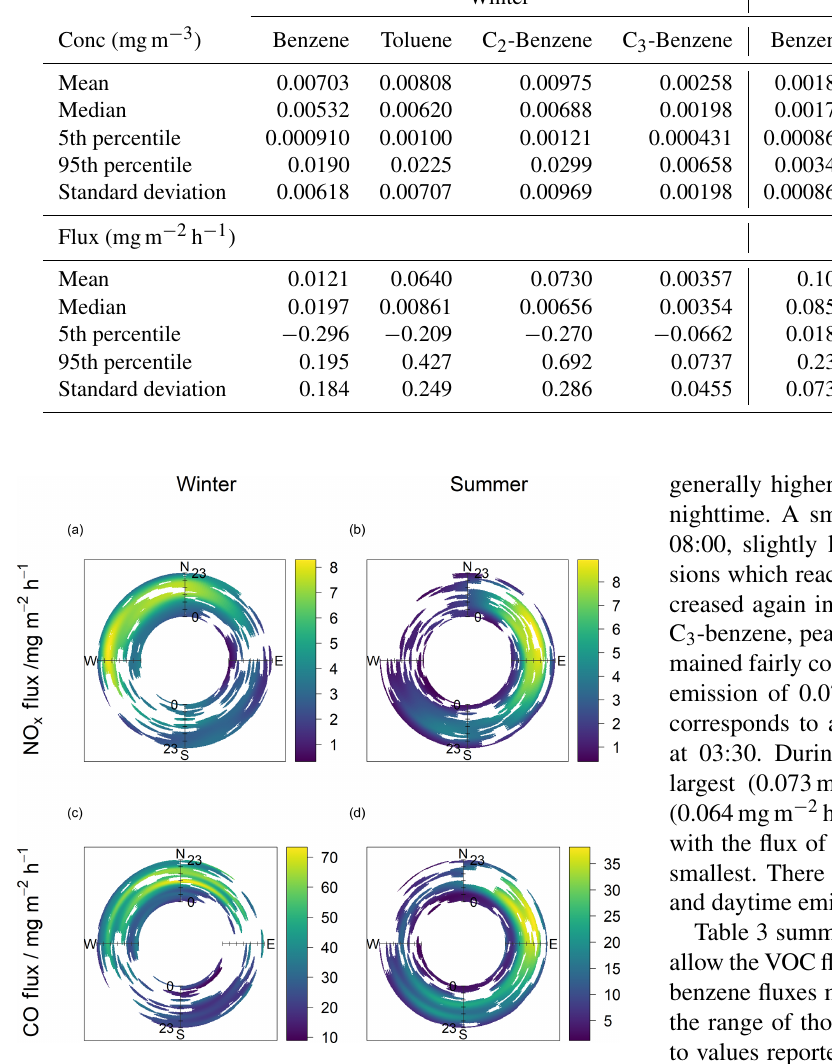
Figure 8. Polar annulus plots for NO x and CO fluxes for both cam- paigns, showing the relationship between mean diurnal flux and wind direction. 0–23 refers to hour of day and the colour scale shows flux in mgm − 2 h − 1